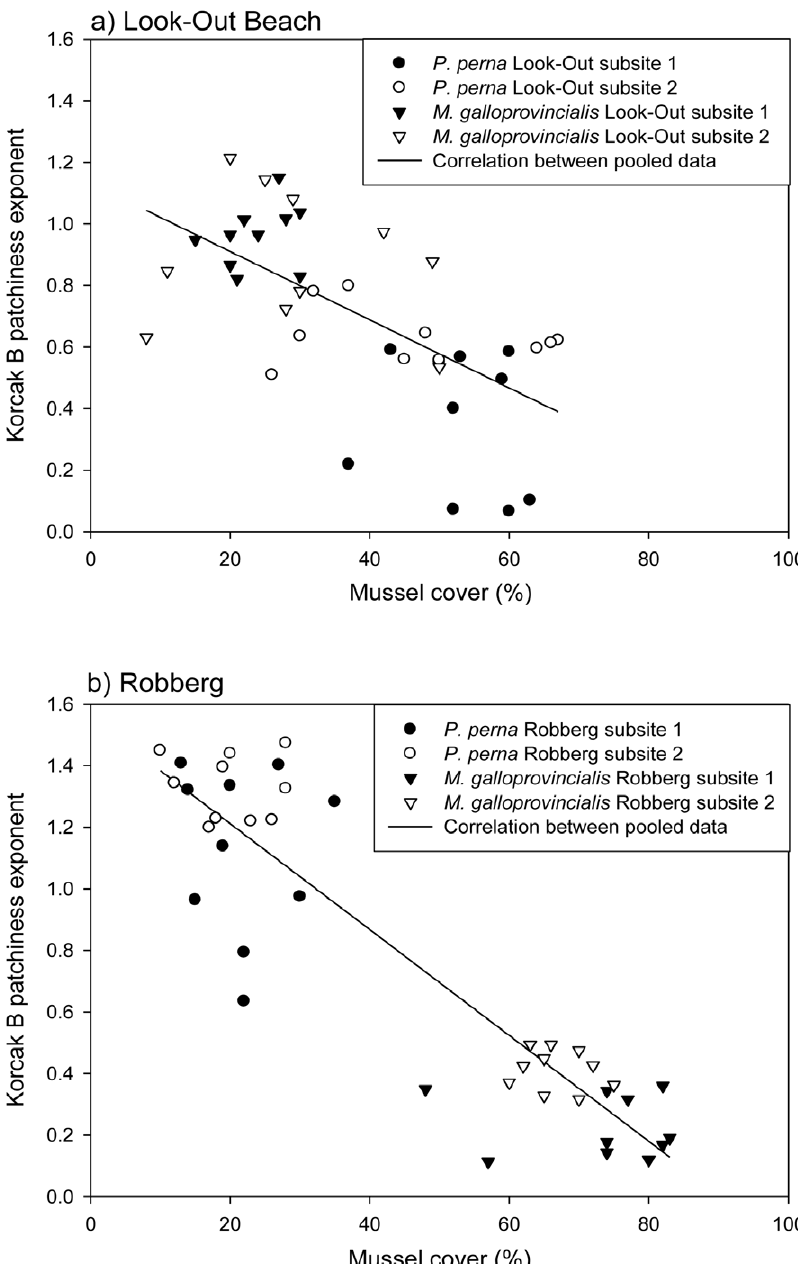
Figure 3. Linear regression between patchiness index and mussel cover at a) Look-Out and b) Robberg.